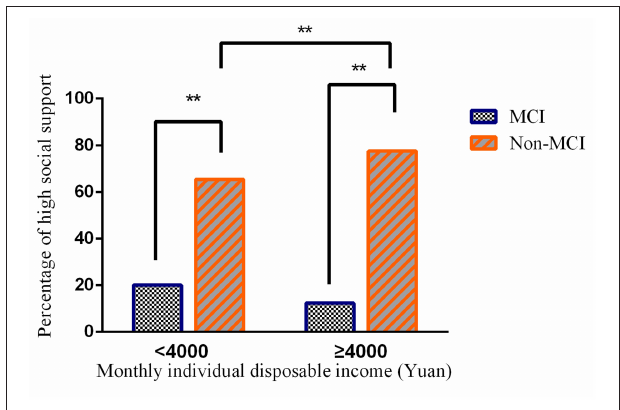
FIGURE 2 | Gaps in social support between study participants with and without mild cognitive impairment (MCI) (** p <